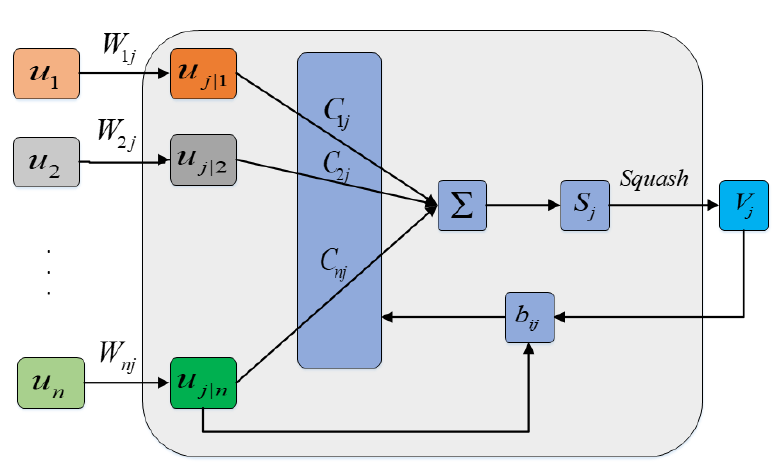
Figure 3. Dynamic routing algorithm.